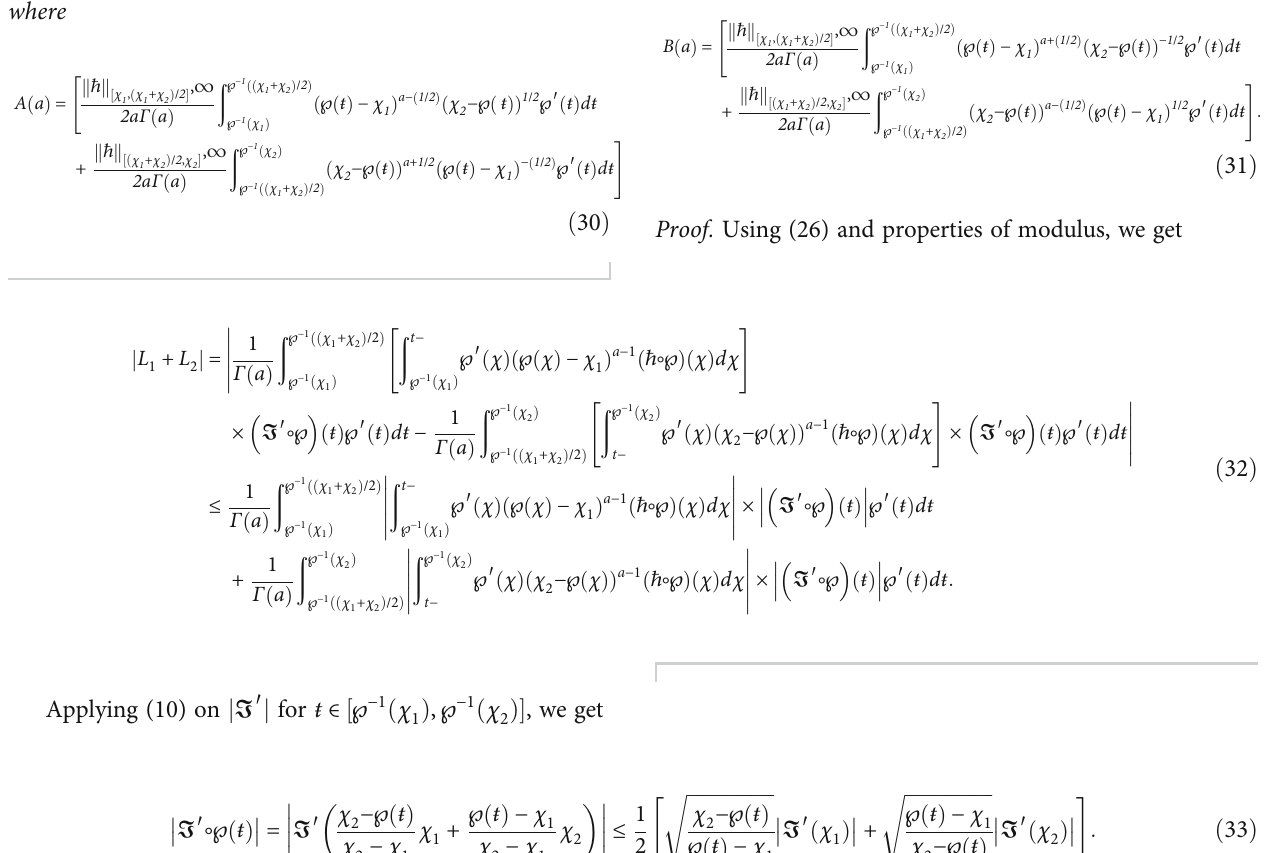
ffiffiffiffiffiffiffiffiffiffiffiffiffiffiffiffiffiffi χ − ℘ ŧ ð Þ 2